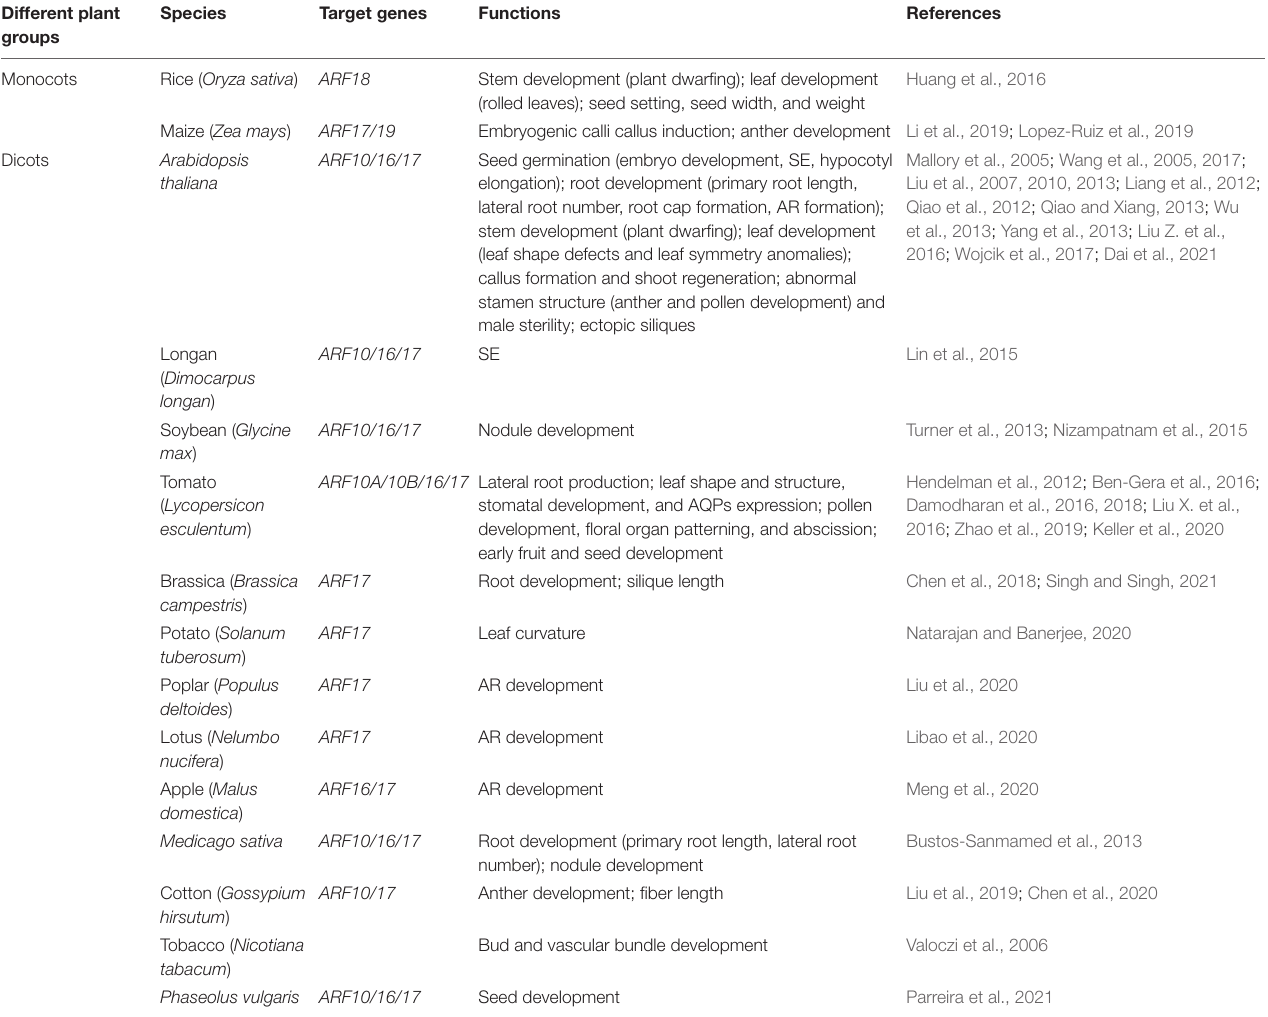
TABLE 1 | List of miR160 identified in various plants during their growth and development. Different plant Species Target genes groups